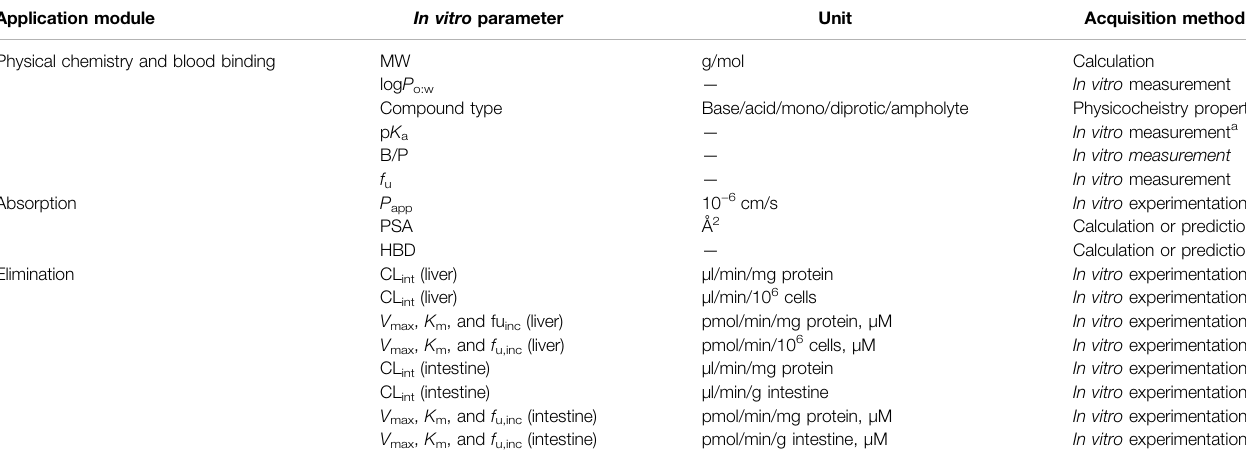
TABLE 1 | In vitro parameters used in each module of the PBPK